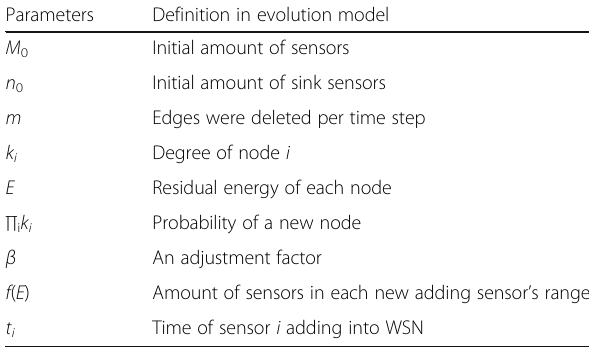
Table 1 Main parameters of the model Parameters Definition in evolution